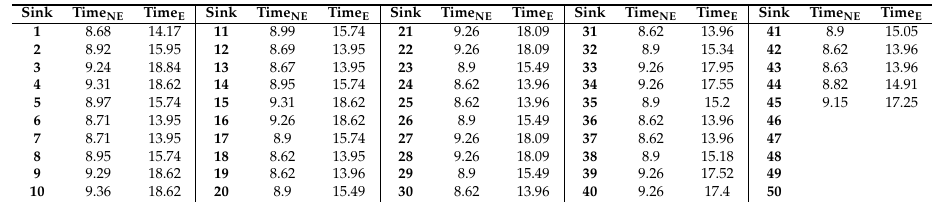
Table A9. Scenario 4: transmission times (in s) for each sink all over the transmission line. (Distance between poles is equal to 200 m, κ = 8, η = 3, NE means no encryption, E means encryption.)